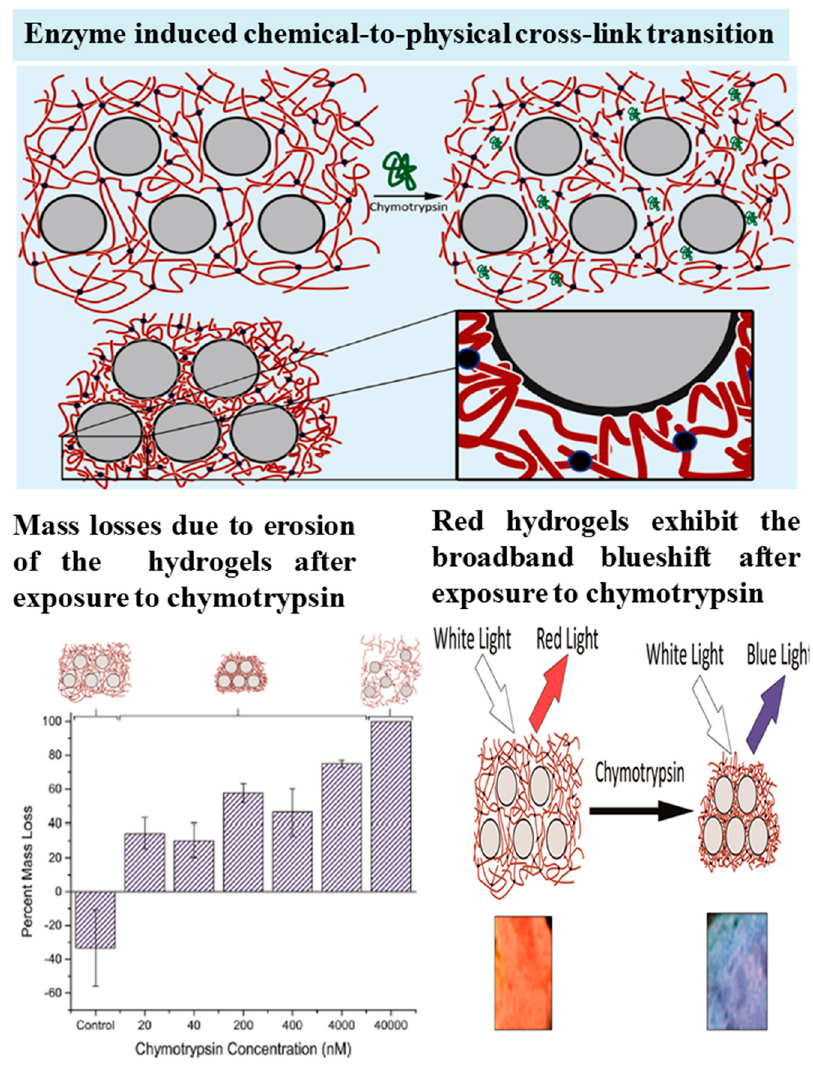
Figure 7. Depiction of the enzyme induced chemical-to-physical cross-link transition and subsequent mass loss and blue shift of nanocomposite hydrogels after exposure to chymotrypsin, reproduced with permission from [140]. Copyright American Chemical Society,